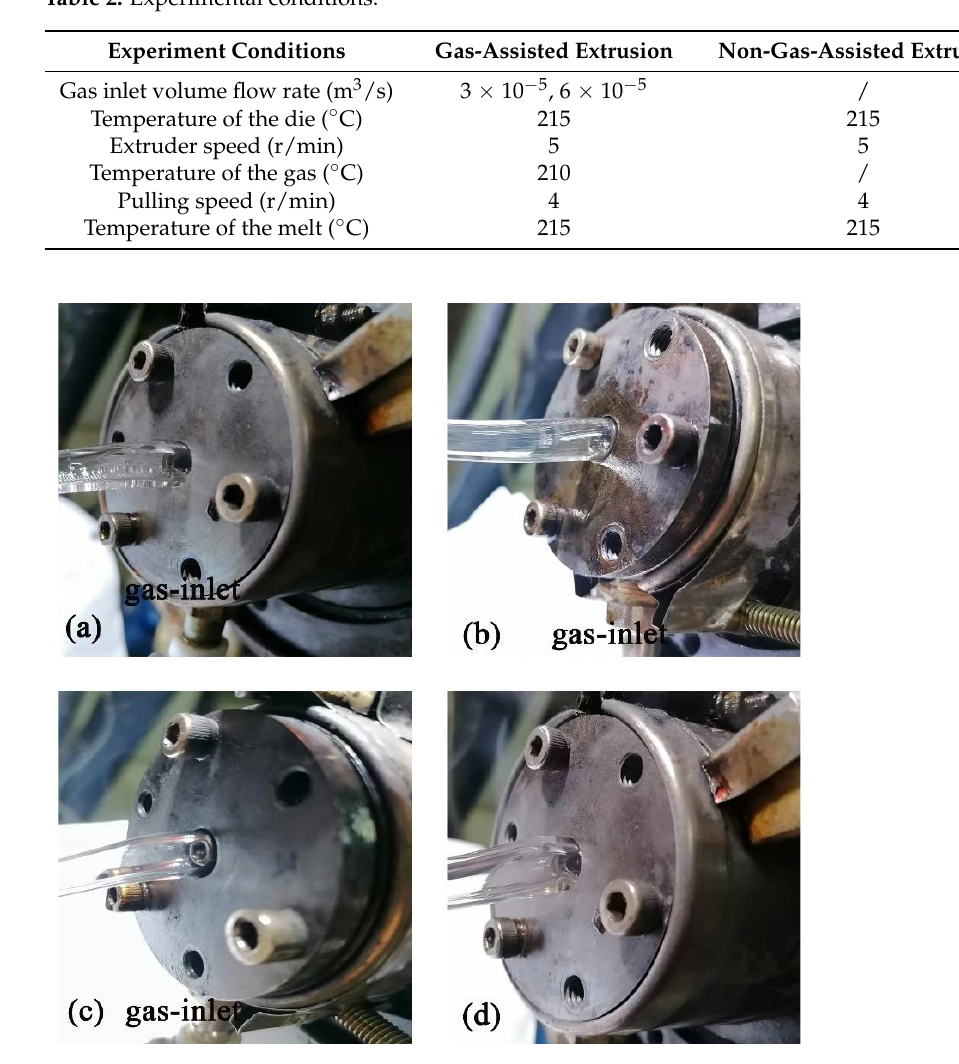
Figure 12. Wall thickness distribution of plastic micro-tubes for gas inlet volume flow rate of 6 × 10 −5 m 3 /s. Table 2. Experimental conditions. Experiment Conditions